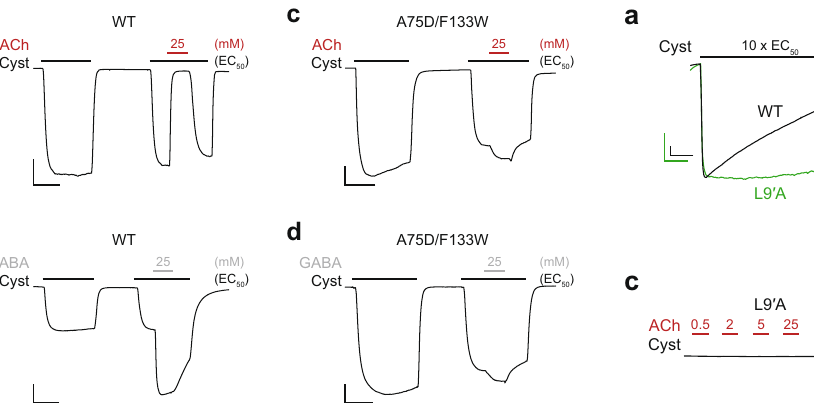
Fig. 5 Contrasting effects of ACh and GABA on wild-type versus the A75D/F133W double mutant ELIC. Representative whole-cell traces for a , b wild-type (WT) and c , d the A75D/F133W double mutant. In each case, the fi rst peak shows the response to a 2 min application of cysteamine at its corresponding EC 50 (black bar). The second peak shows the response to another 2 min application of cysteamine, again at its EC 50 , but which was interrupted by a 40 s pulse where 25 mM ACh red bar; ( a , c ) or 25 mM GABA gray bar; ( b , d ) was co-applied. The x - and y -axis of the scale bar in each panel corresponds to 1 min and 0.5 µ A, respectively.